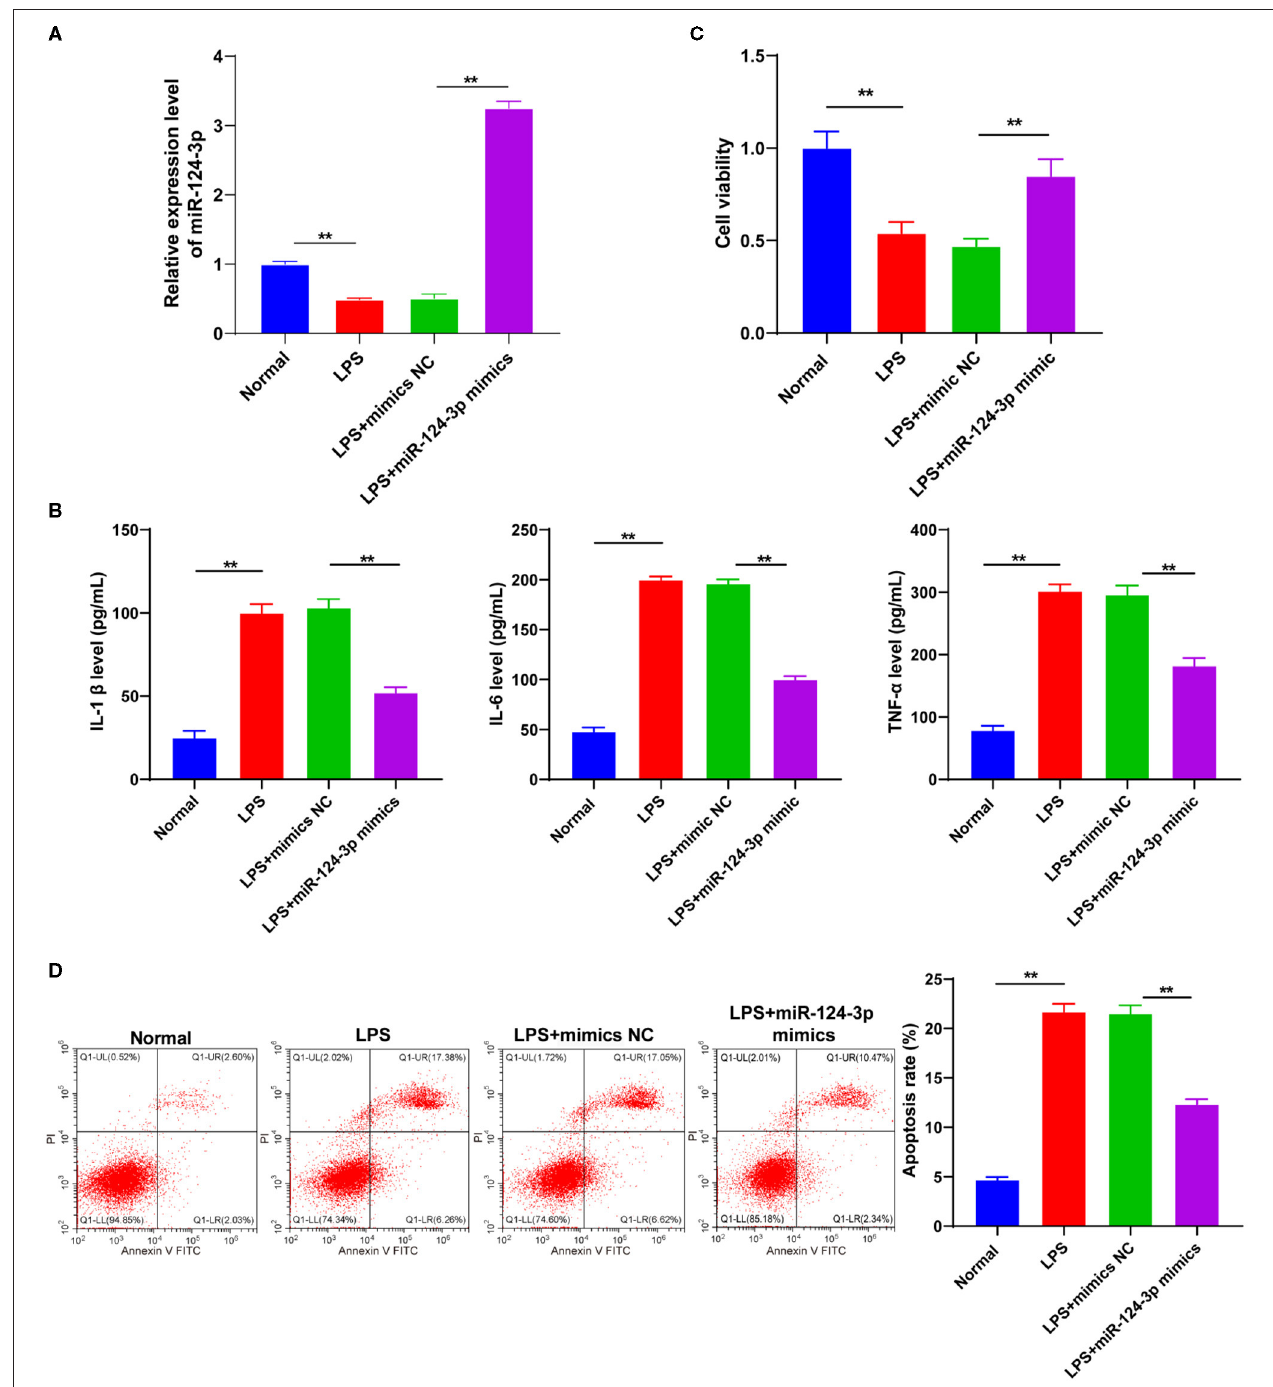
FIGURE 2 | Overexpression of miR-124-3p inhibited LPS-induced inflammatory response and apoptosis in microglia. LPS-induced microglia were transfected with miR-124-3p mimic. (A) Transfection efficiency of miR-124-3p was confirmed using RT-qPCR; (B) Inflammatory factors IL-1 β , IL-6, and TNF- α in microglia were detected using ELISA; (C) Cell viability was detected using MTT; (D) Cell apoptosis was measured using flow cytometry. The cell experiment was repeated three times independently. Data are expressed as mean ± standard deviation and analyzed using two-way ANOVA, followed by Tukey’s multiple-comparison test, ** p < 0.05.